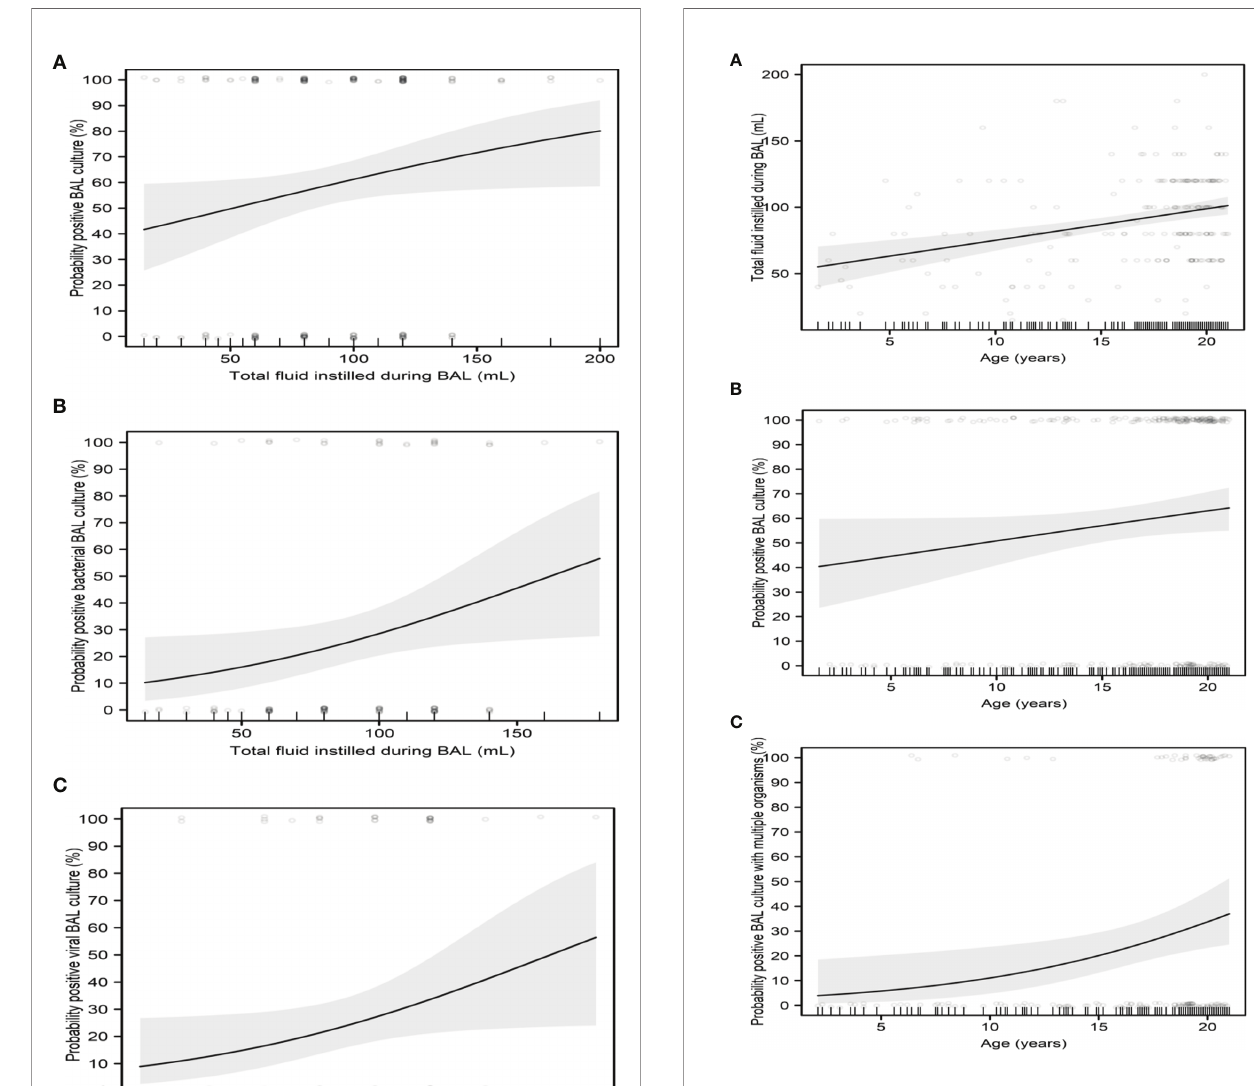
FIGURE 3 | Impact of age on BAL. (A) Total fl uid instilled during BAL. (B) Probability of positive BAL culture. (C) Probability of positive BAL culture with multiple organisms. Regression curves are shown as solid lines, bounded by shaded 95% con fi dence intervals. Scatterplots show raw patient measures, jittered slightly for clarity in the probability